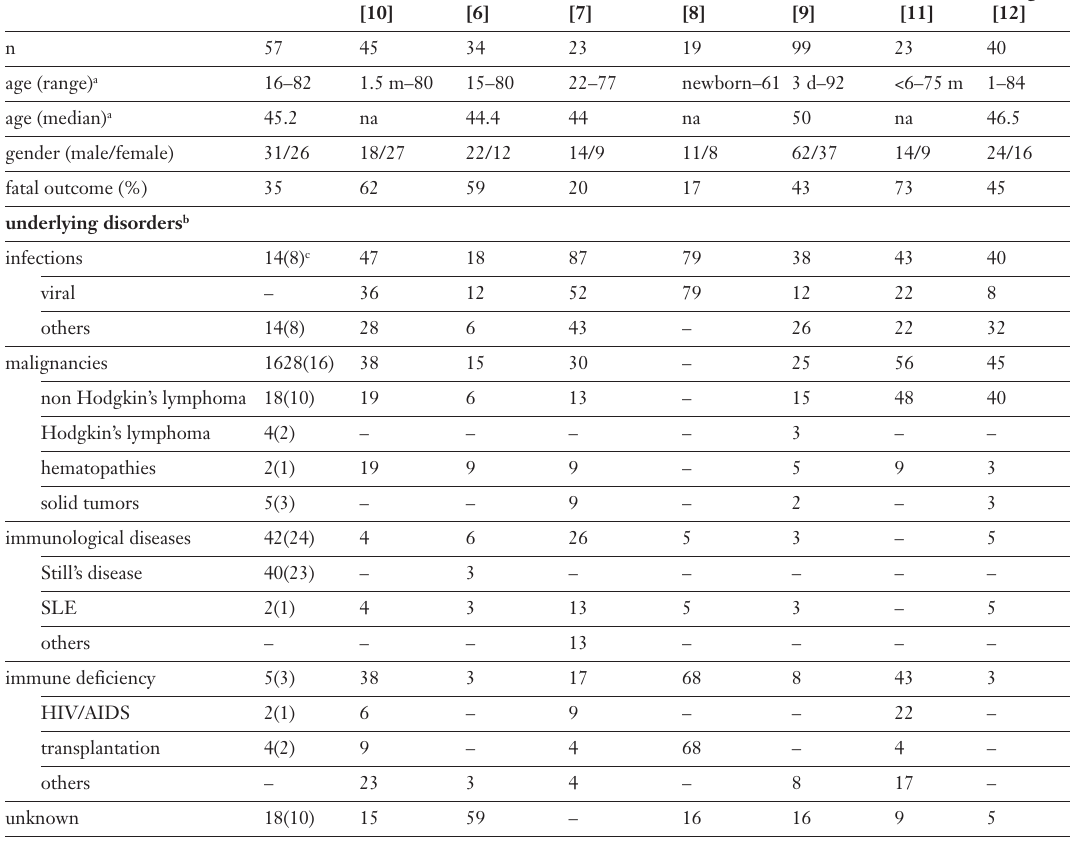
Comparison of the different patient pop- ulations